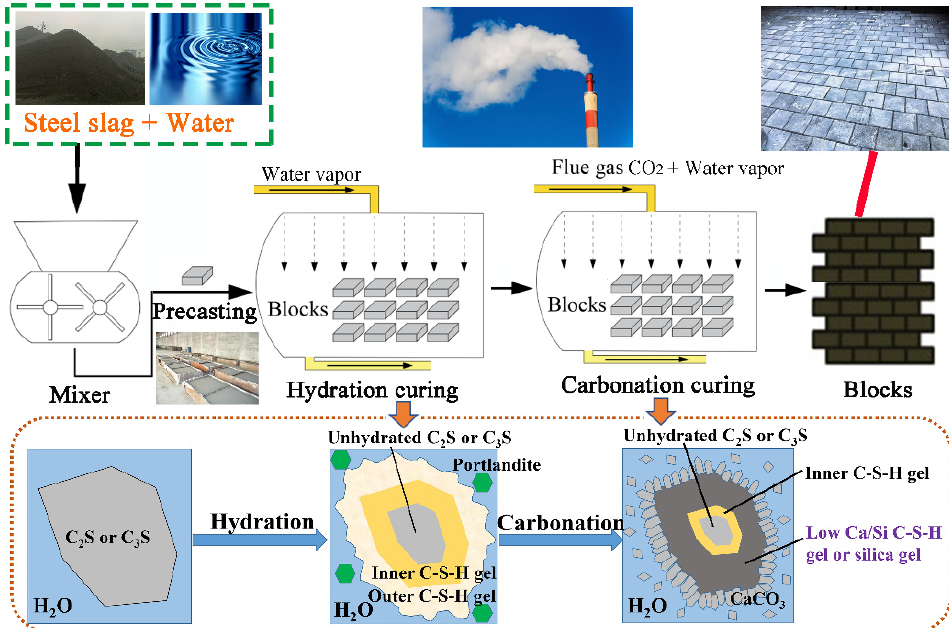
Figure 1. Hydration and in situ flue gas carbonation curing of SS for building materials, together with known reaction mechanisms.